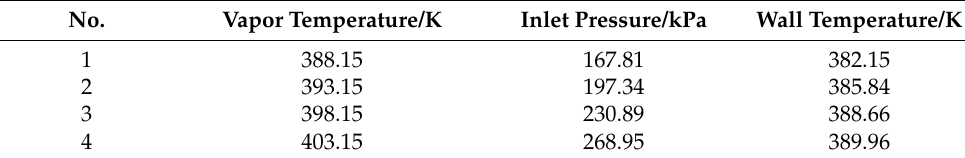
Figure 5. Schematic diagram of experimental setup in Li’s study. Table 2. Experimental conditions of verified data.